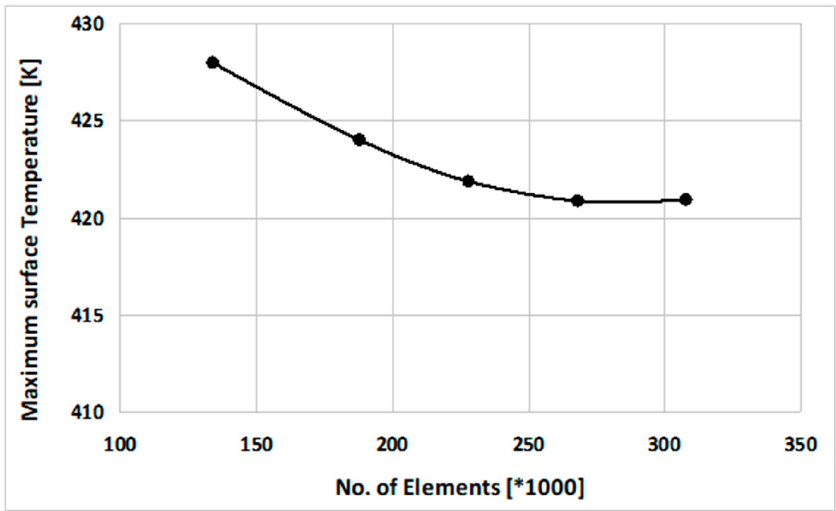
Figure 4. The mesh independence test of the FE model of clutch system.